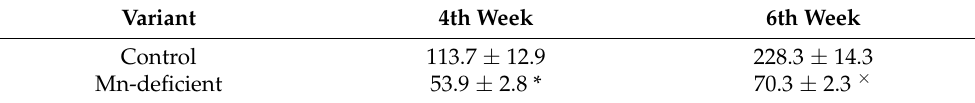
Table 1. The Mn amounts per seedling at the 4th and 6th weeks of the